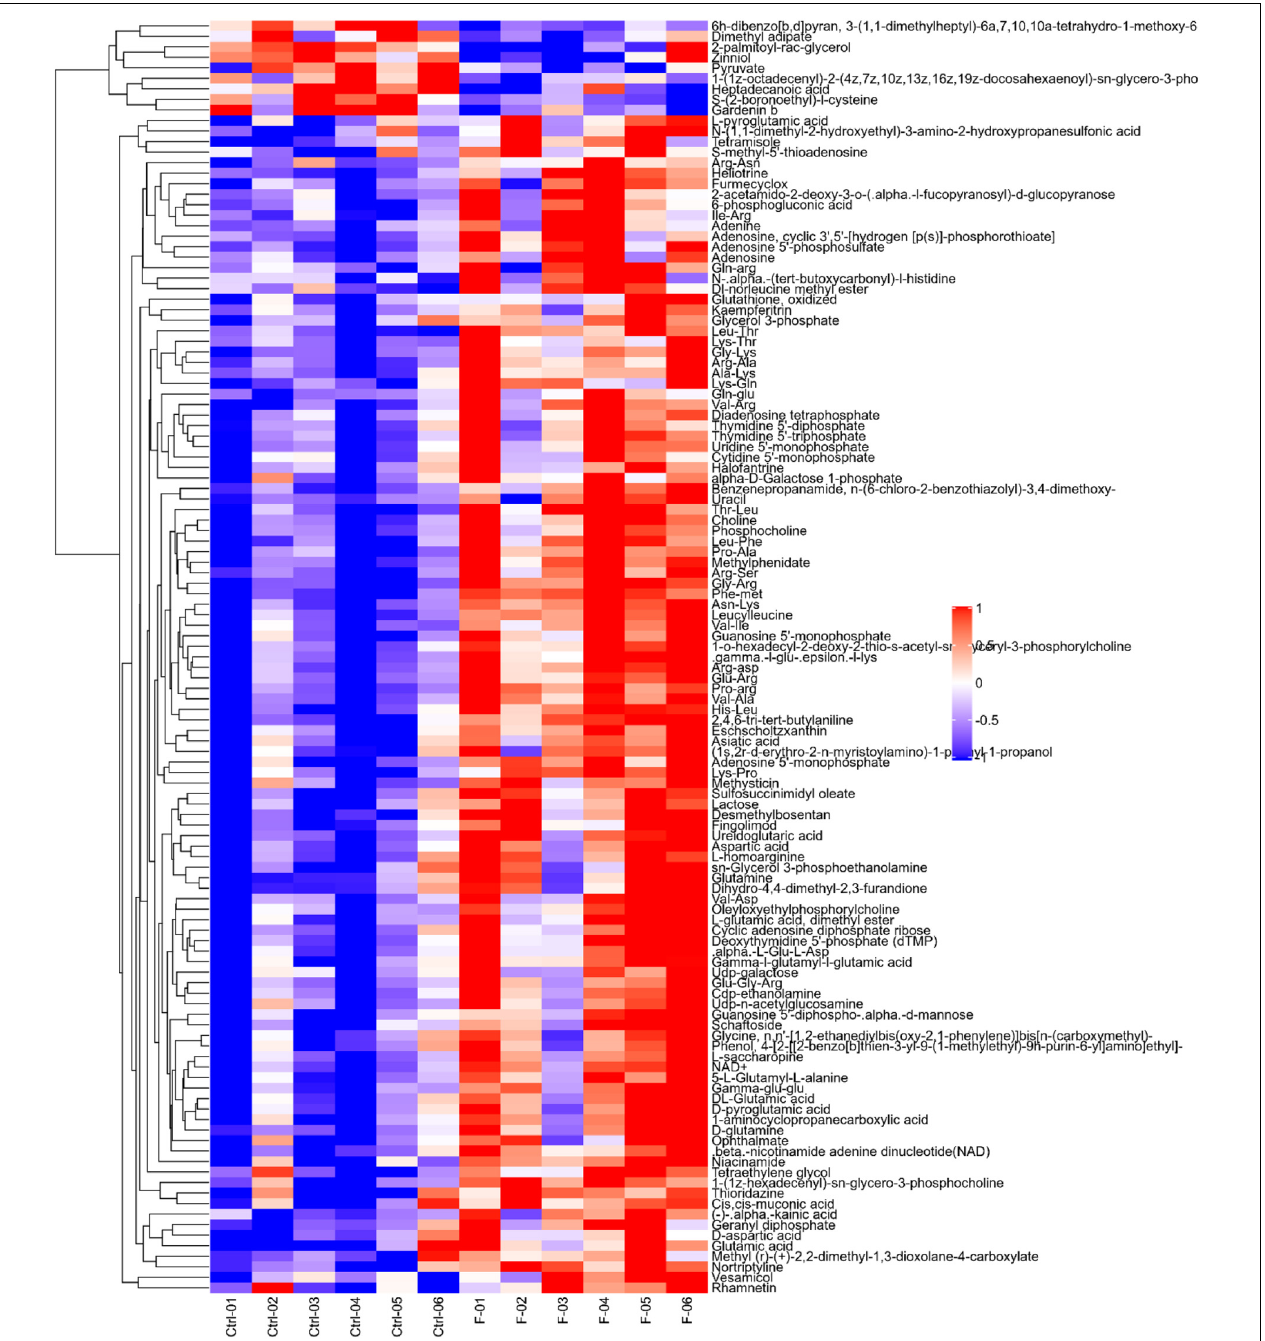
FIGURE 4 | Heatmap of differentially expressed metabolites in LMH cells infected with FAdV-4. Each row in the figure represents a differential metabolite (the ordinate is the metabolite with significant differential expression), and each column represents a group of samples (the abscissa is the sample information). Red represents significant up regulation, blue represents significant down regulation, color depth indicates the degree of up regulation and down regulation, and metabolites with similar expression patterns gather in the same cluster on the left.